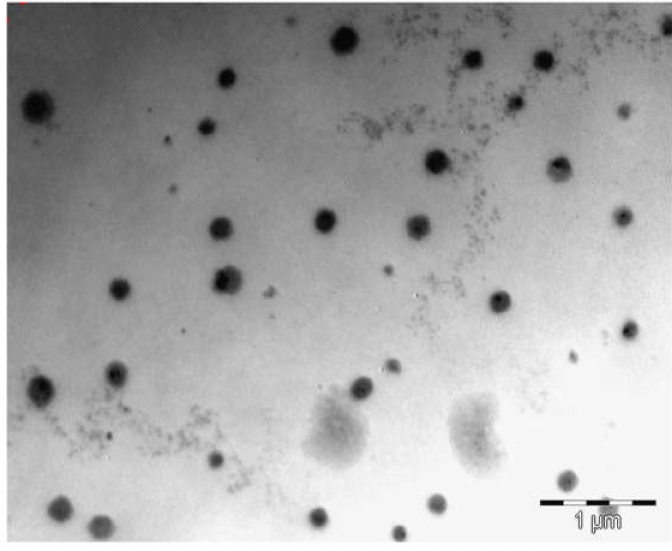
Figure 6. TEM micrograph of optimised NCC (OPT-NCC).